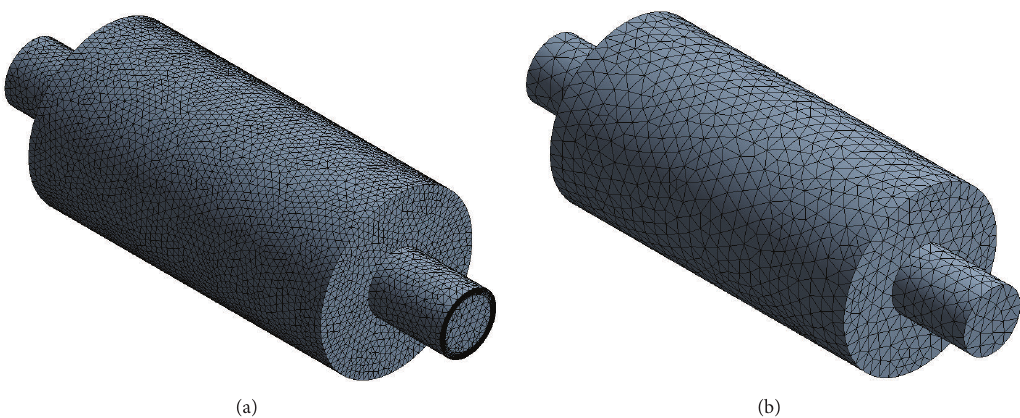
Figure 2: Geometry of meshes for the expansion chamber silencer: (a) CFD mesh and (b) acoustic mesh.